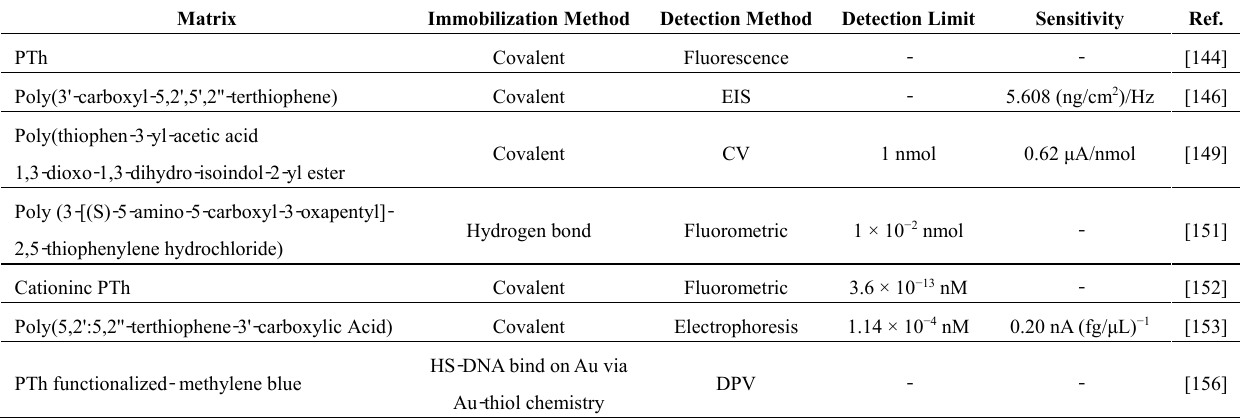
Table 2. Polythiophene (PTh)- and PTh-derivative-based DNA sensors and their performance in the detection of DNA